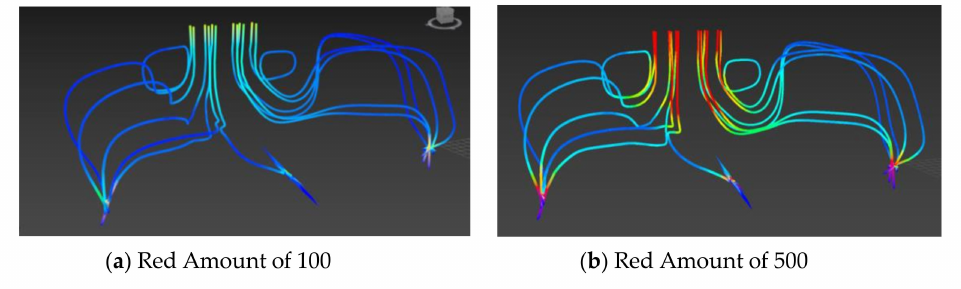
Figure 9. Red Amount of ( a ) 100 vs. ( b )